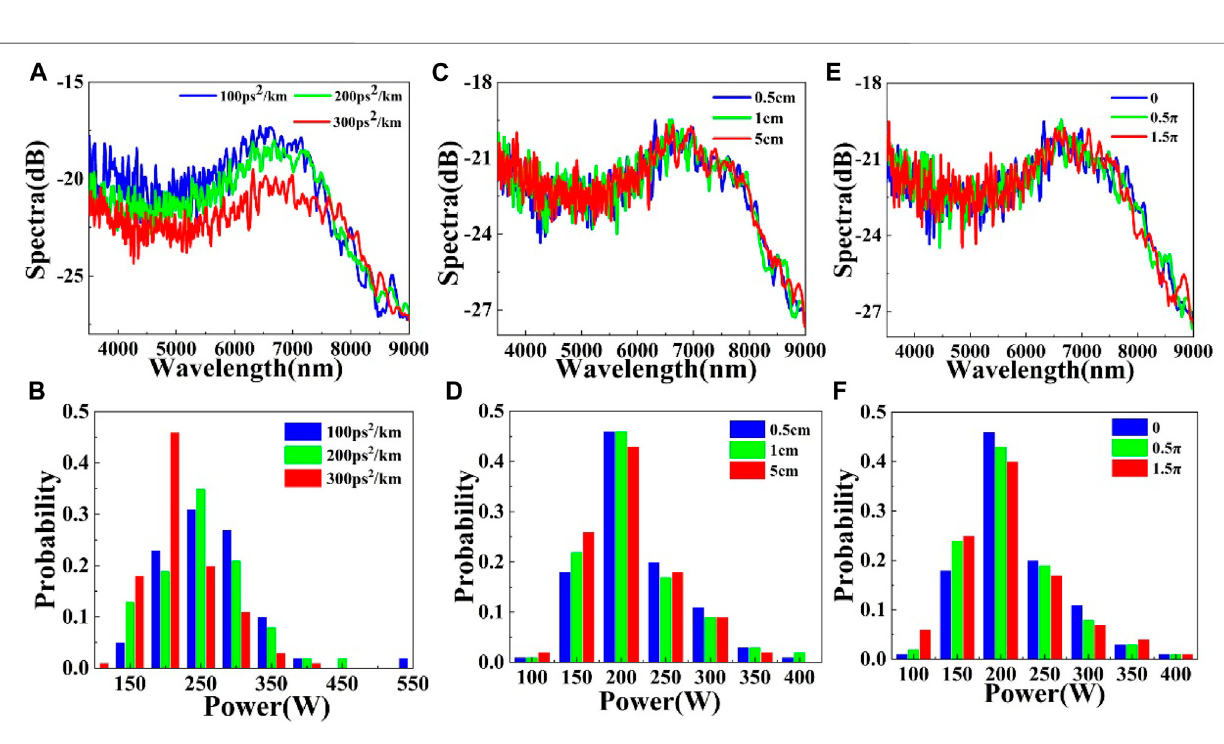
Frontiers in Physics |